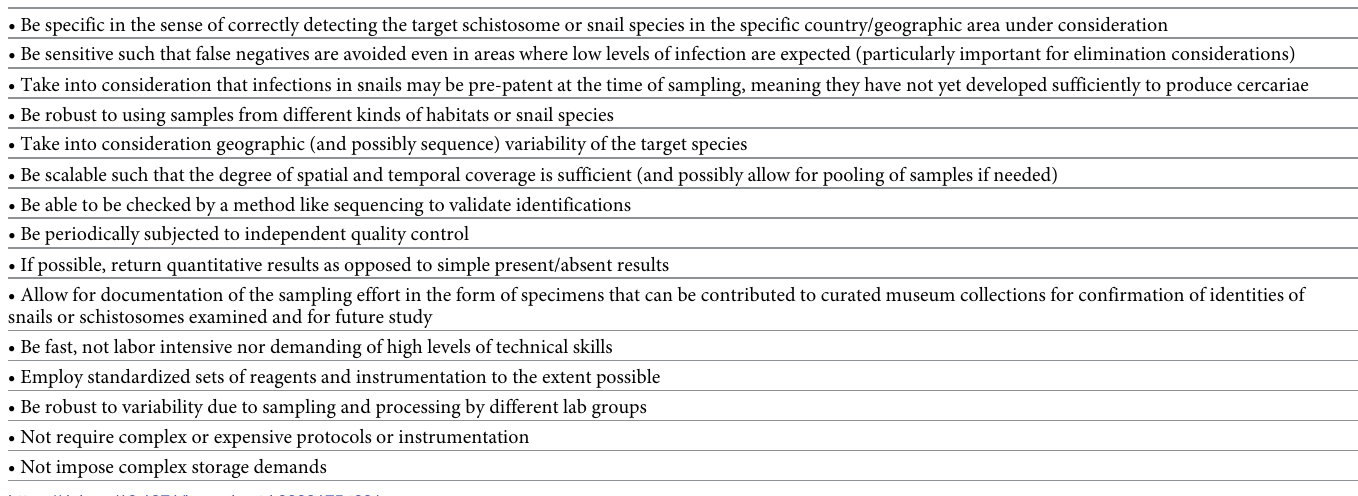
Table 1. The ideal diagnostic test to answer the stated PICO question should include the following characteristics.